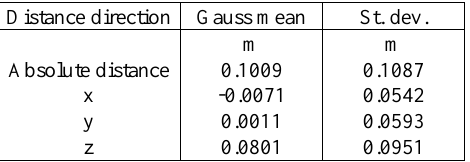
Table 4 . Values obtained after applying the Cloud-to-Cloud tool between DJI Matrice 300 RTK L1 (compared) and DJI Phantom 4 (reference) clouds, without Cloud registration.